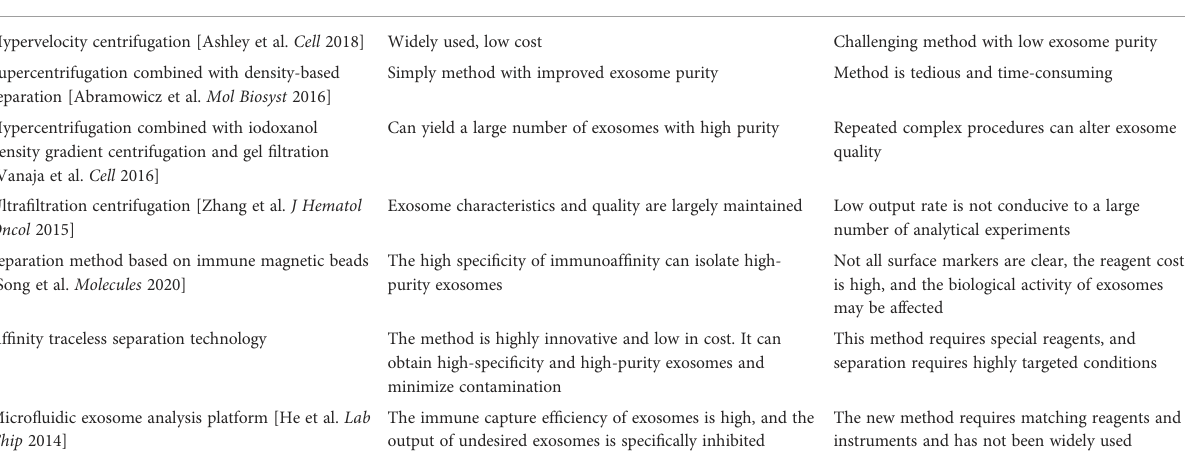
TABLE 1 Extraction and analysis of